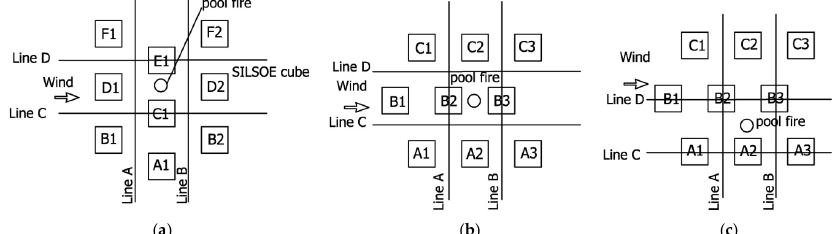
Figure 1. Model city buildings arrangement (marked squares), diesel pool fire location (circle) and wind direction (arrow) for ( a ) Case 1 where the Silsoe cube is also indicated; ( b ) Case 2; and ( c ) Case 3.